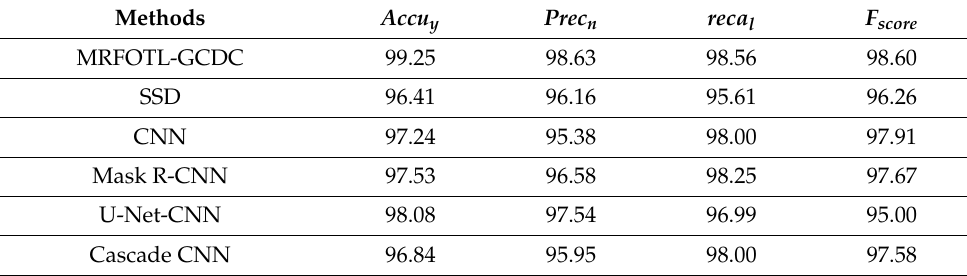
Figure 10. TR loss and VL loss analysis of MRFOTL-GCDC system. Table 4. Comparative analysis of MRFOTL-GCDC system with other existing